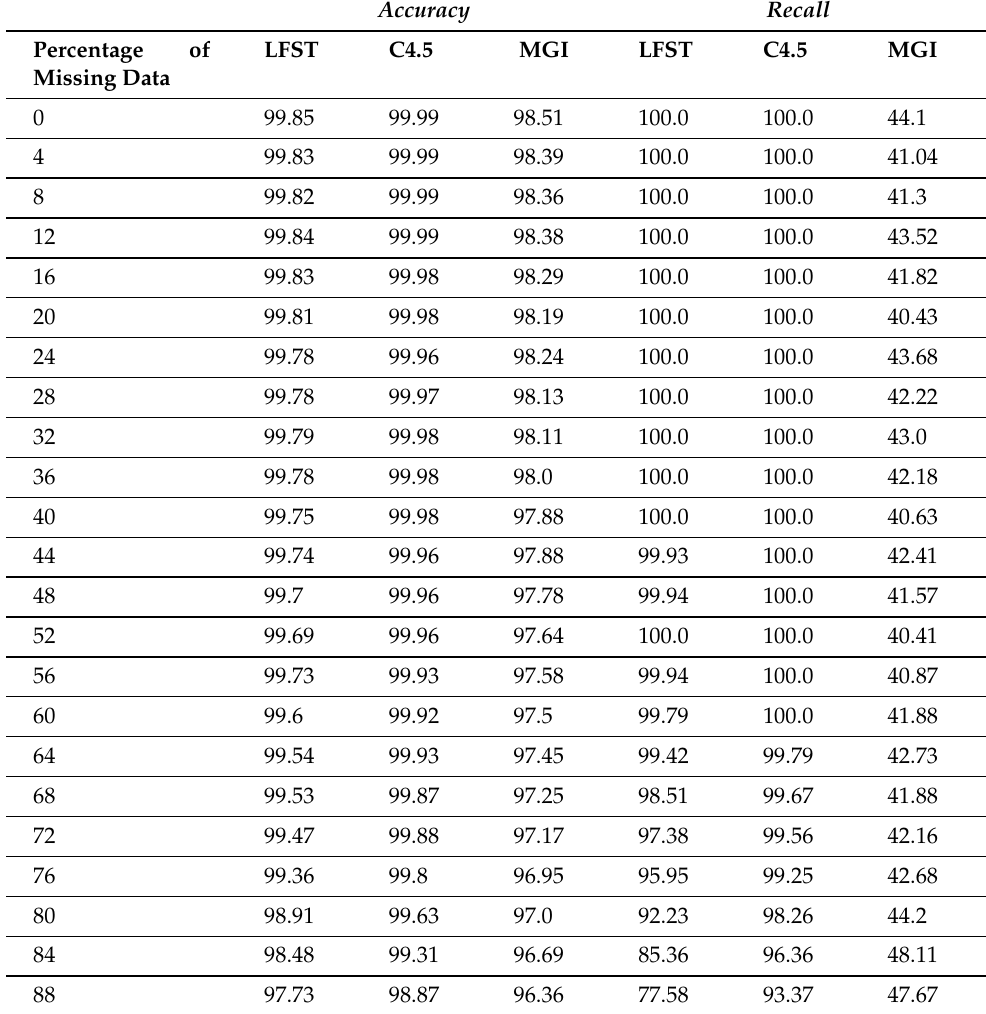
Table 1. Average accuracy and recall for the three algorithms in GridWorld.